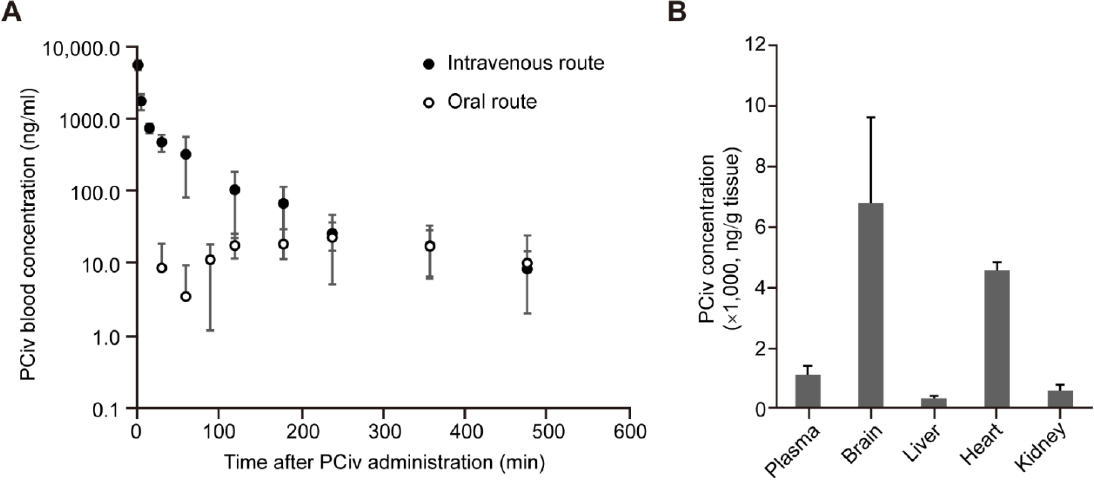
Figure 3. Pharmacokinetic analysis and tissue distribution of PCiv. ( A ) Pharmacokinetic analysis of blood PCiv levels at each indicated time point following intravenous or oral administration of PCiv (10 mg/kg) determined by ultra-performance liquid chromatography ( n = 4 rats for oral and 5 rats for intravenous administration). ( B ) Quantification of PCiv levels in each indicated tissue (ng/g tis- sue weight) determined by ultra-performance liquid chromatography ( n = 3 rats, tissues collected